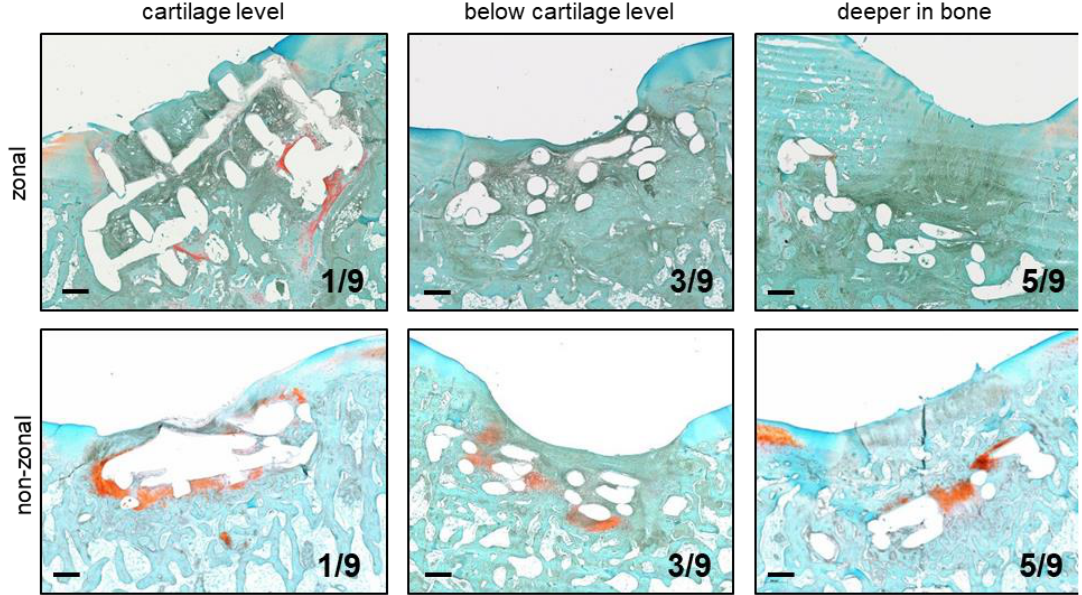
Figure 3. Implant location after 6 months in vivo according to the histology of cartilage defects. First column: Implant with the location of PCL surface at cartilage level. Second column: Implant with the location of PCL surface ≤ 1-fold construct thickness below cartilage surface. Third column: Implant with the location of PCL surface >1-fold construct thickness below cartilage surface. Numbers: constructs/group. Safranin O/Fast Green staining. Zonal, non-zonal n = 9. Representative pictures are shown in the middle and right columns.